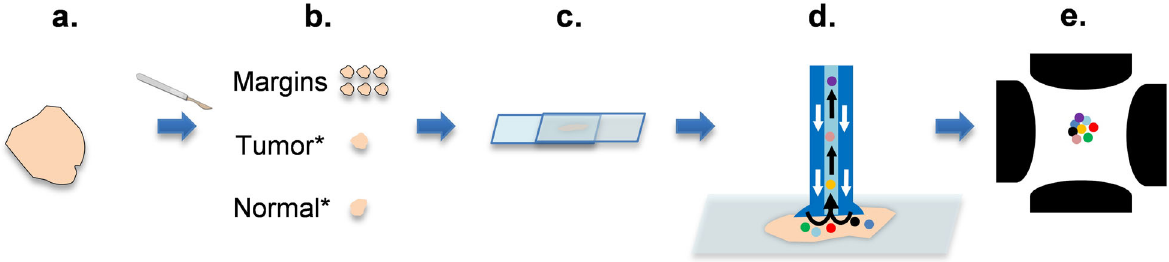
Fig. 1 Work fl ow for intraoperative MS of surgical breast tissue. a Lumpectomy, ( b ) tissue allocation, ( c ) tissue smear using squash prep, ( d ) surface extraction using liquid microjunction surface sample probe (LMJ-SSP), and ( e ) metabolite pro fi les generated using electrospray ionization-ion-trap mass spectrometry. *Tumor and normal samples allocated in the frozen section room when adequate tissue is available for